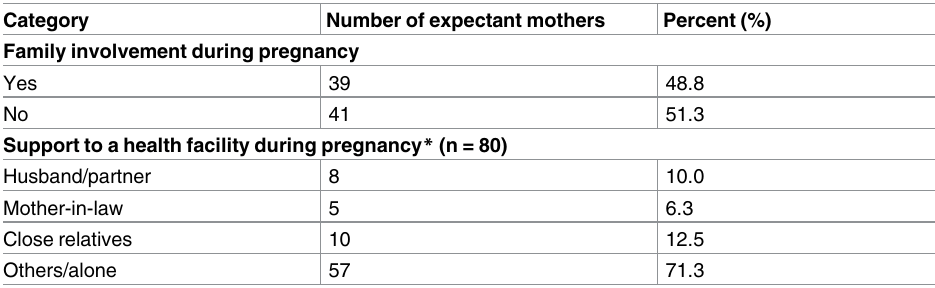
Table 5. Family support during